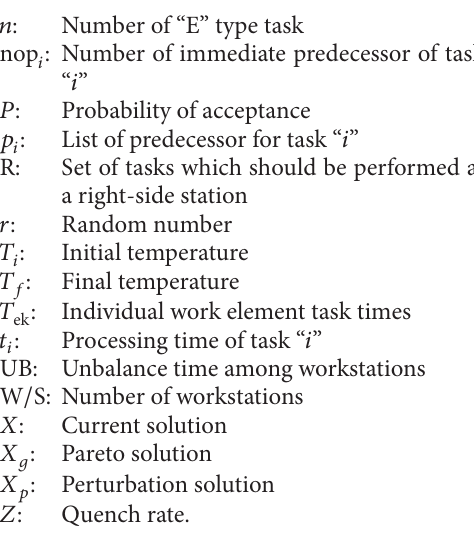
number of searches to locate near optimal solution.